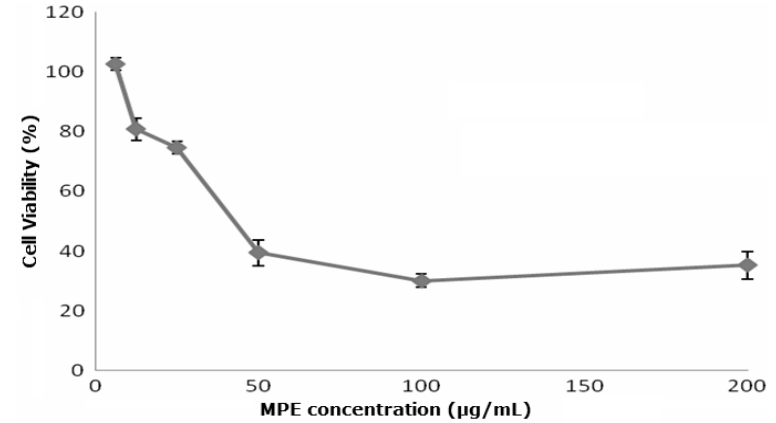
Figure 1. Effect of MPE on MCF-7 viability after 24 hour incubation